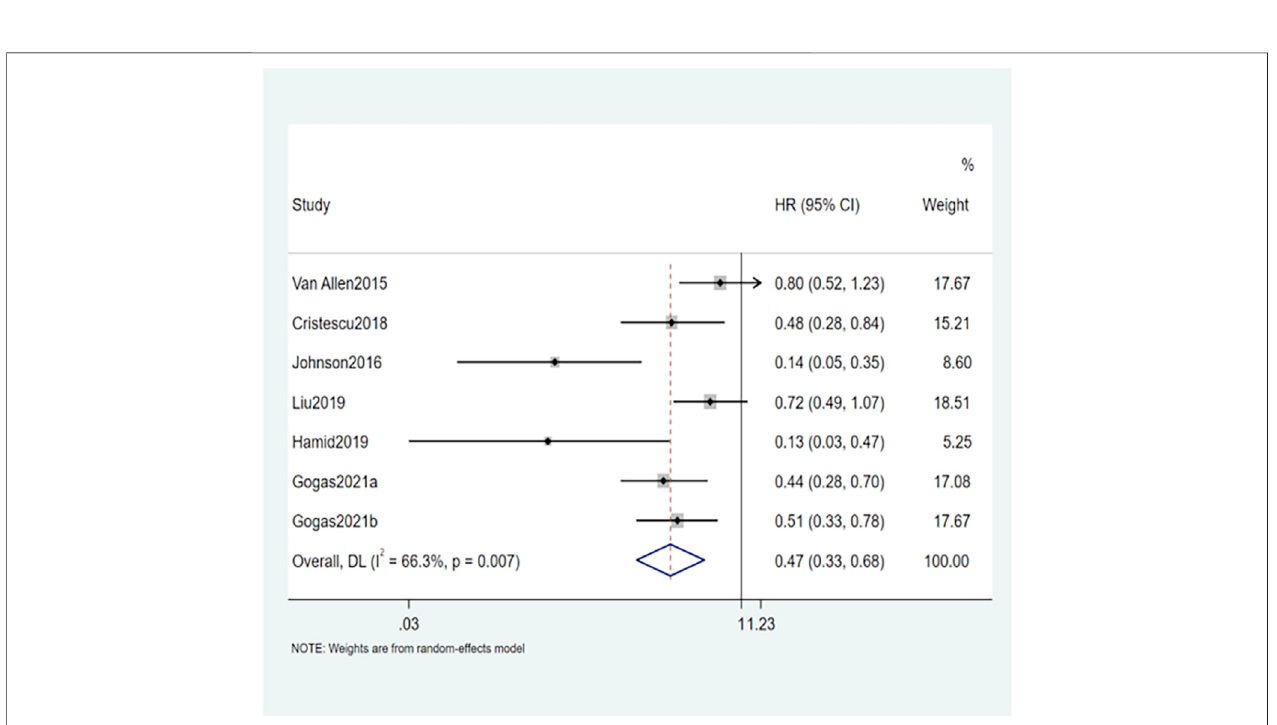
FIGURE 3 | Forest plot of association between TMB and